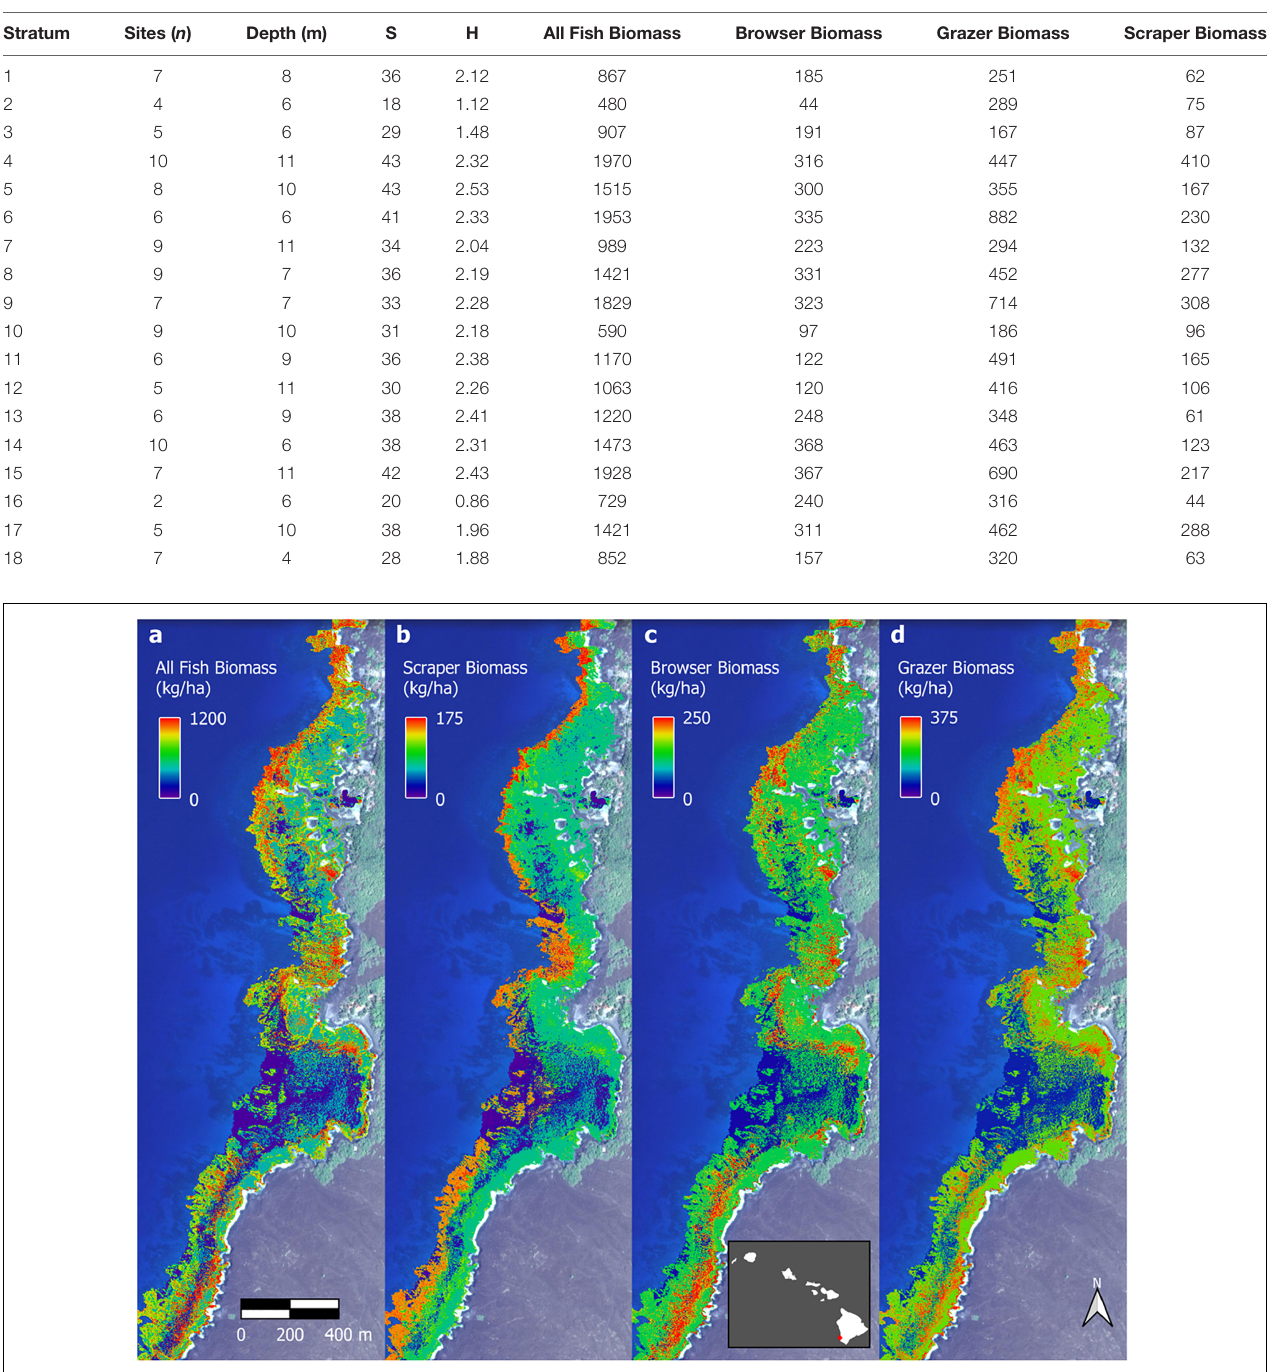
TABLE 2 | Mean field-based results by map stratum of water depth and species richness (S), Shannon diversity (H), and biomass (kg ha − 1 ) of all fish, as well as biomass for browser, grazer, and scraper trophic groups. Stratum Sites ( n )